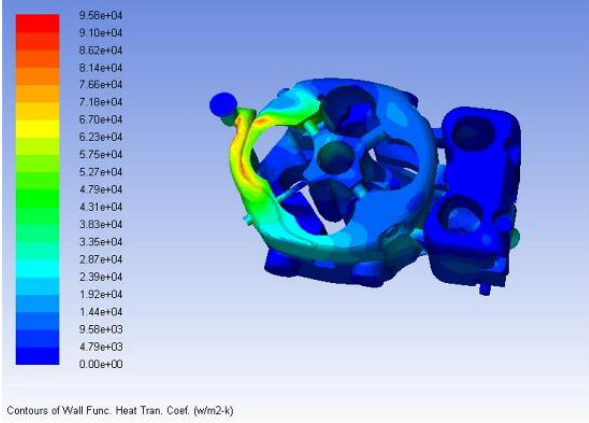
Figure 7. Contours of the cooling water jacket’s heat transfer coefficient.